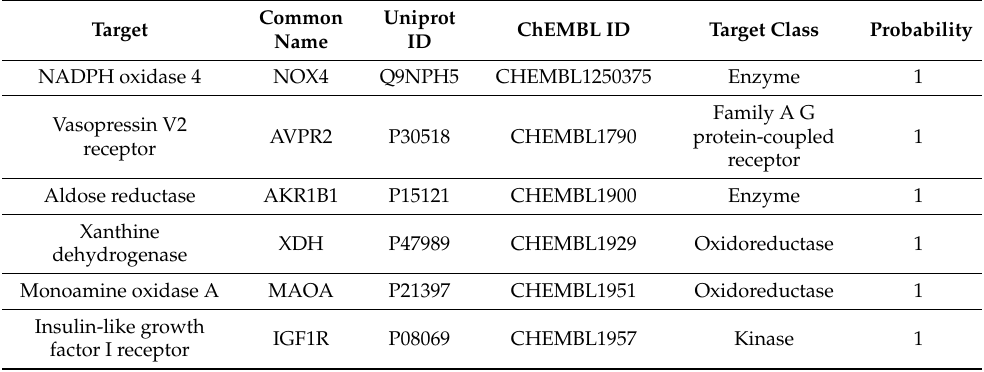
Table 12. Main molecular targets of the phytochemical quercetin obtained through the analysis in Swiss Target Prediction